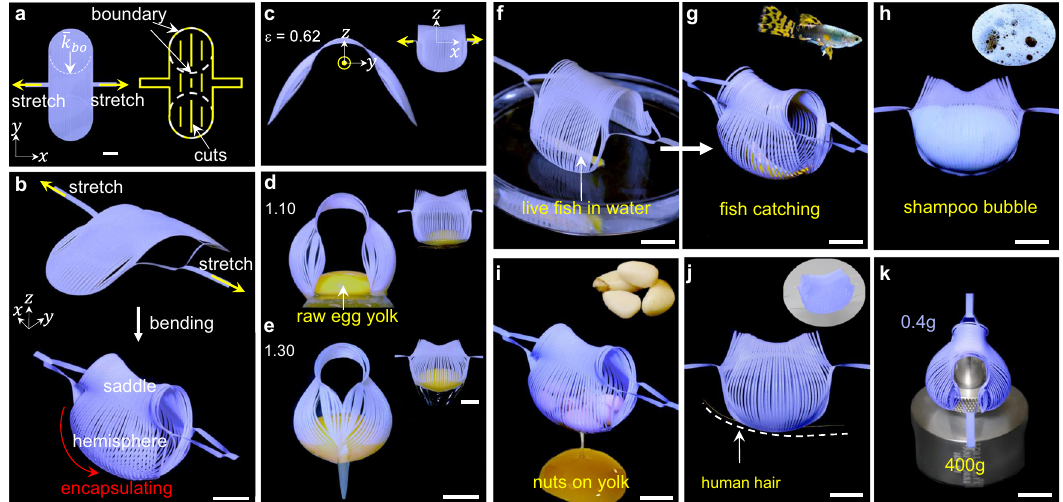
Fig. 6 Programmable delicate and noninvasive kirigami gripper. a 2D precursor composed of an array of two circular units bridged with a biconcave unit. (cid:1) k fi nes the initial boundary curvature of the units. Yellow arrows are the direction of the uniaxial stretching. Yellow lines and white dashed lines bo de represent the cuts and the boundaries, respectively. b Isometric view of the morphology from bending to encapsulating upon stretching. Red arrows represent the morphing direction of the hemisphere. c – e Side views of the grasping process of a raw quail egg yolk with the increasing applied strain from 0.62 to 1.3, respectively. The inset shows the corresponding front views. f , g Encapsulating a live fi sh from a petri dish fi lled with water. h Grasping the super-soft shampoo bubbles from the surface of the water. i Collecting the granular objects (pine nuts) from the super-soft surface of a raw egg yolk. j , k Grasping a human hair ( j ) and a deadweight (400 g, k ). Scale bars = 10 mm.